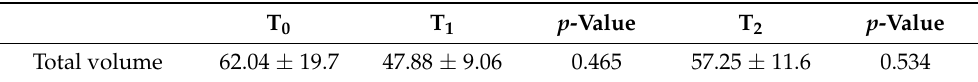
Table 4. Cross-sectional area (cm 2 ) in the different planes (mean + SD).